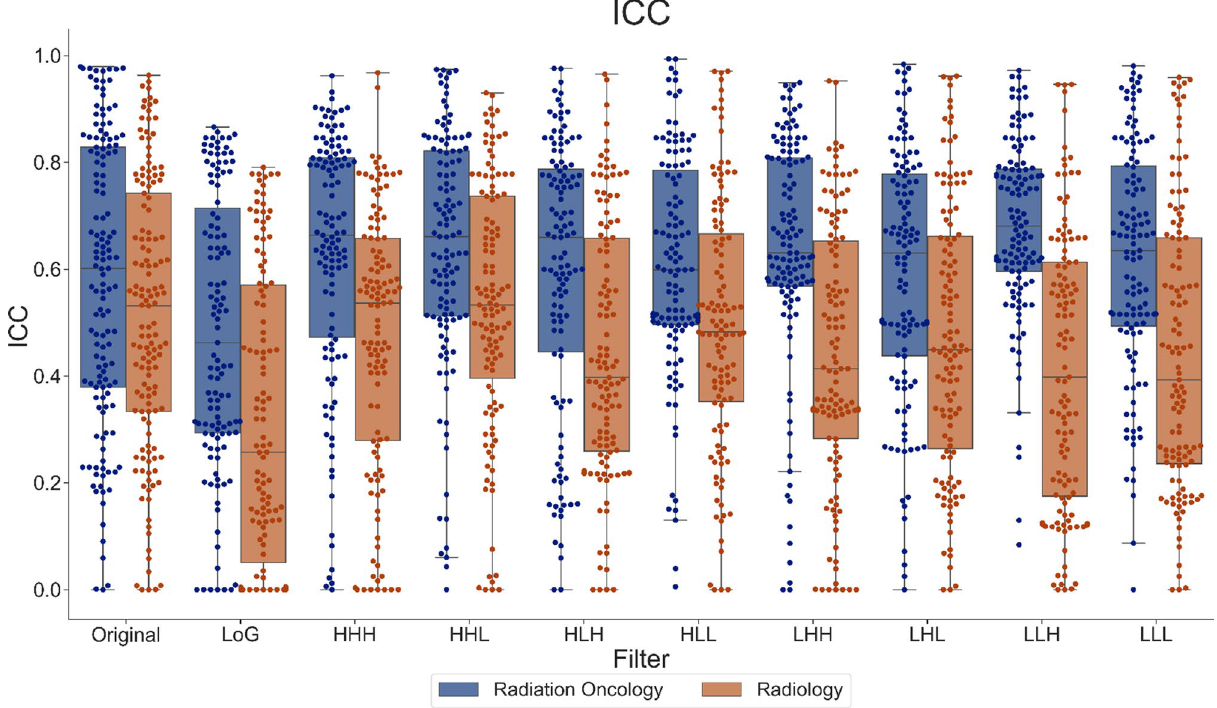
Figure 4. Comparison of ICC of radiomics based on image filter. ICC values for each discipline for radiomic features extracted from each image filter applied illustrates the distribution of ICC values based on image filter